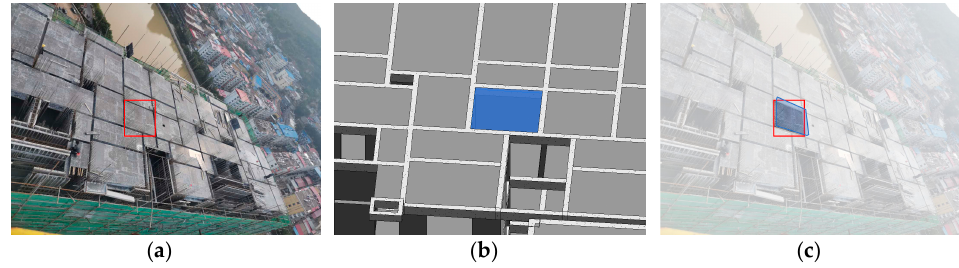
Figure 6. The process of a component: ( a ) Detection result; ( b ) BIM element; ( c ) Registration result.